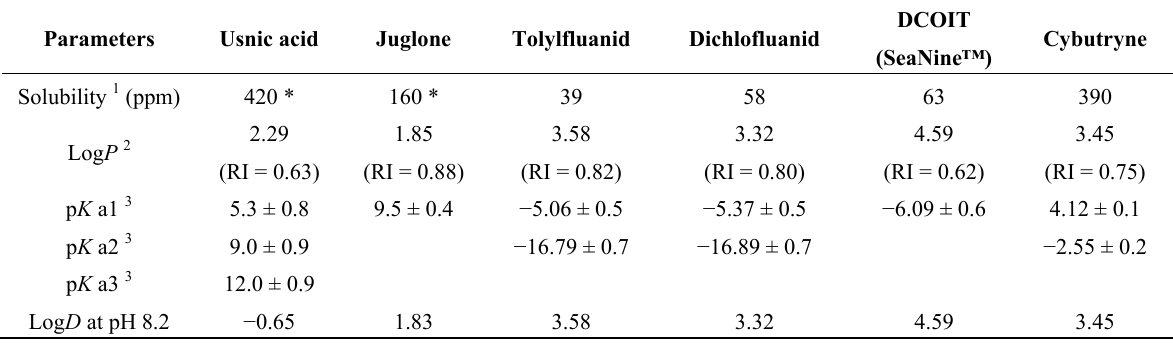
Table 3. Calculated physico-chemical parameters (using Advanced Chemistry Labs